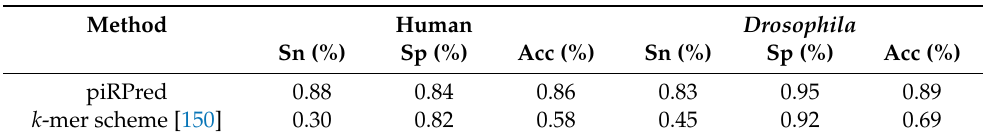
piRPred outperforms the k-mer scheme, especially upon testing on the human piRNA